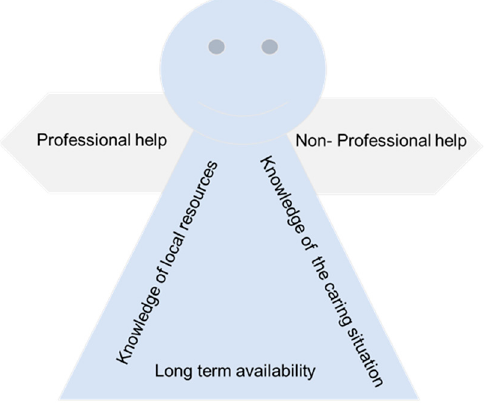
Figure 2. Profile of the dementia case manager.